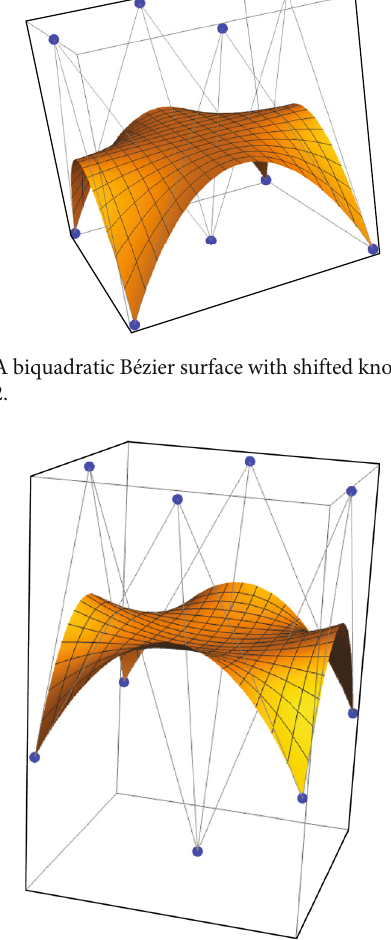
Figure 2: The quasi-minimal biquadratic Bézier surface with shifted knots for η = 0 : 2 and λ = 0 : 2 for given boundary control points and optimal point obtained from Equation (79).